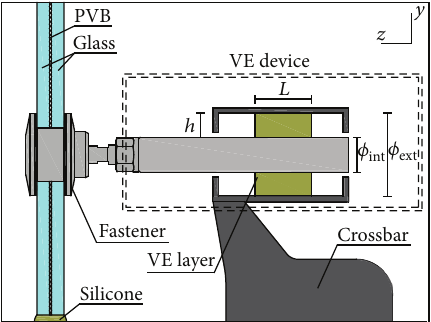
Figure3:Cross-sectionofapossiblefour-holeVESC(detailofpoint support with viscoelastic device).